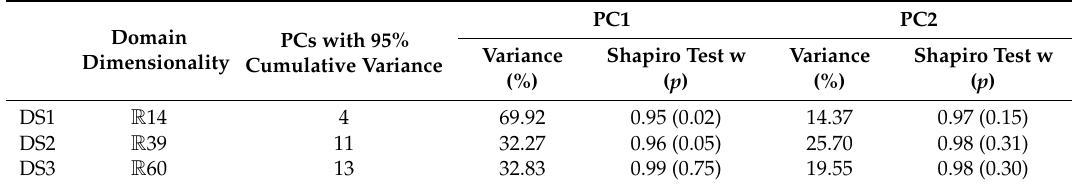
Table 2. Summary of each dataset’s target domain with univariate calculations of distribution normality in the top two PC scores.